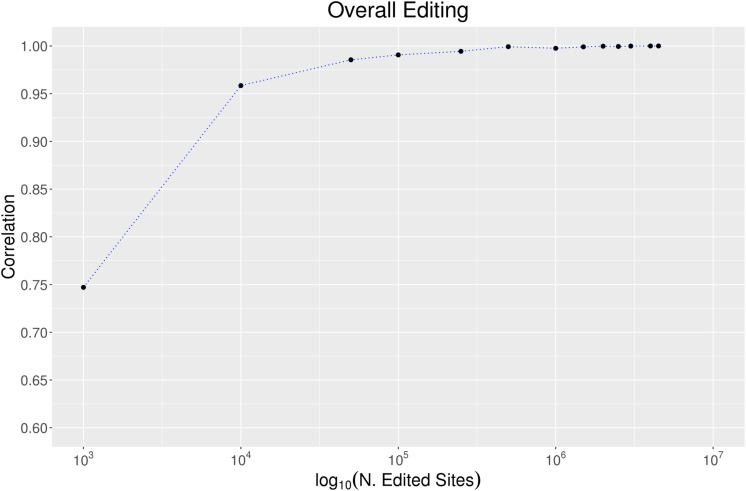
The effect of the number of sites on the overall editing. We calculated the overall editing calculated in all 123 GTEx samples using a growing number of positions randomly selected from REDIportal database. The Pearson correlations between the overall editing measured per each group of positions and the same metric on the entire REDIportal collection are depicted.